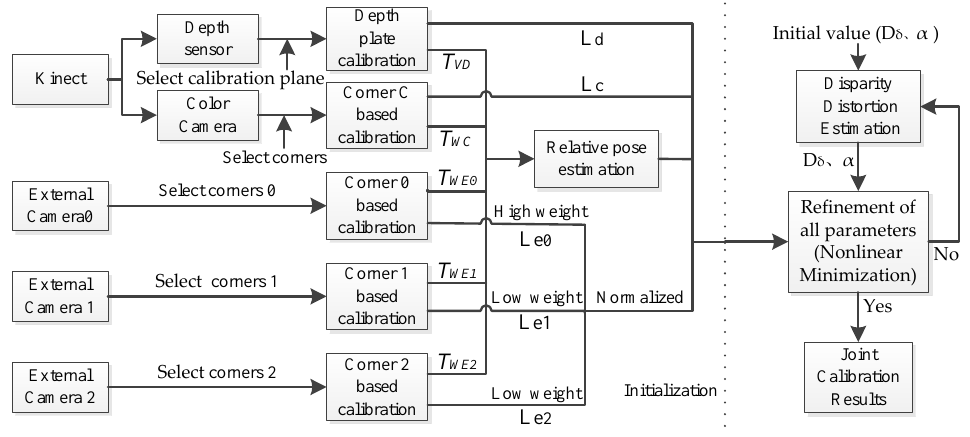
Figure 1. The illustration of work flow of the proposed method.